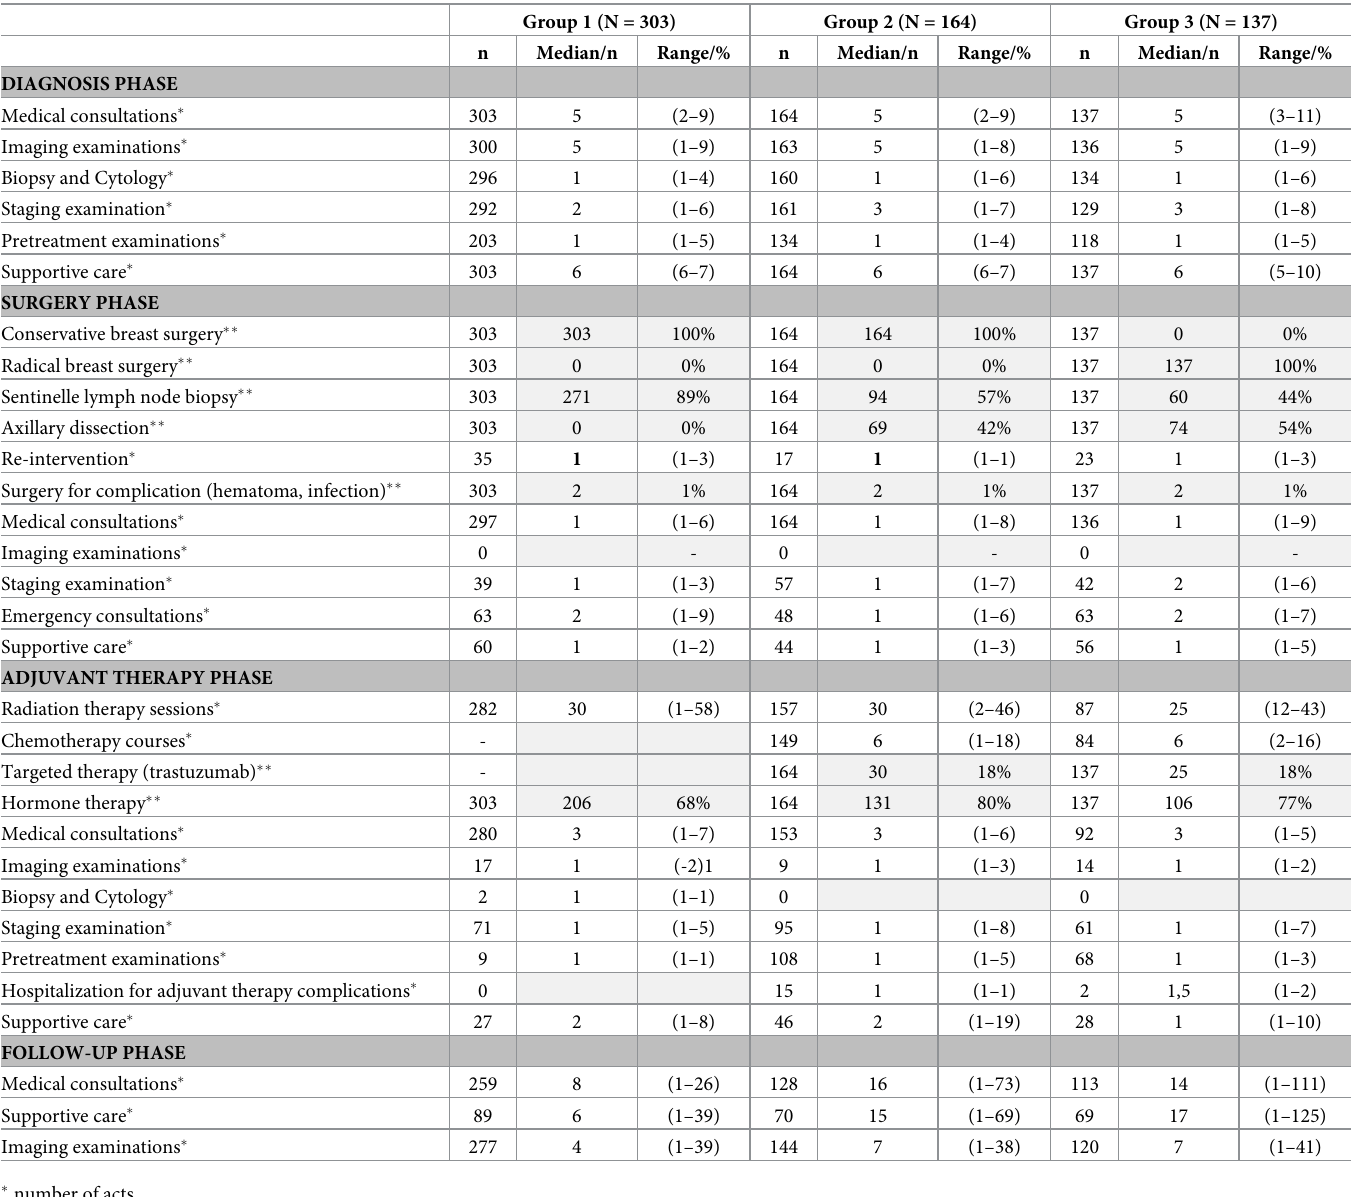
Table 2. Consumed resources (median and range are given for consuming patients only